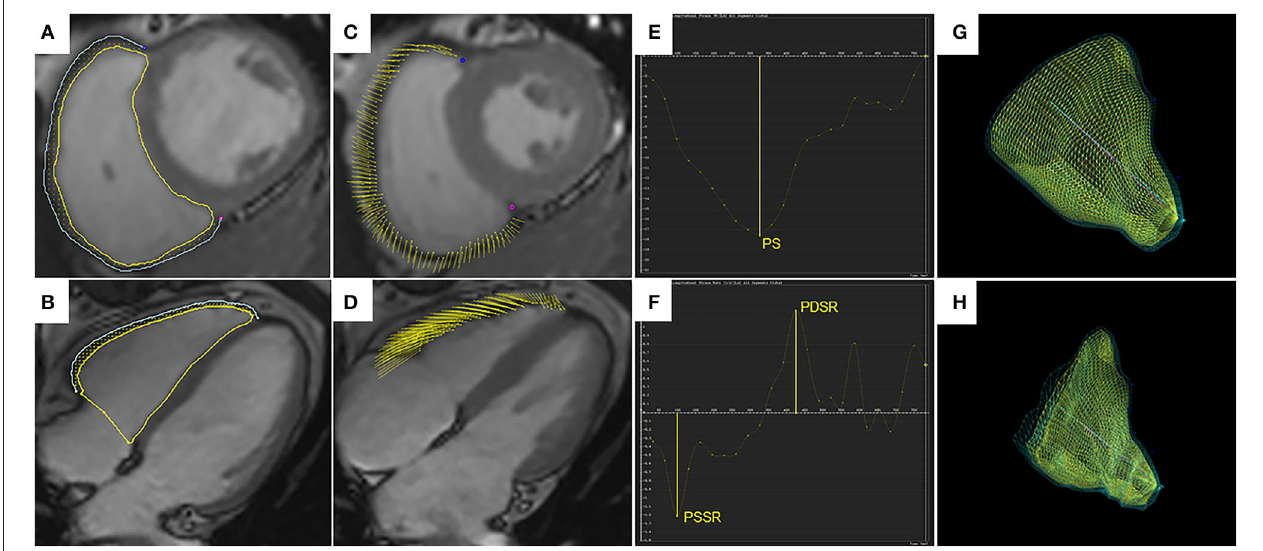
FIGURE 1 | Right ventricular tissue tracking using cardiac magnetic resonance imaging. Right ventricular (RV) contours are delineated on the short-axis SSFP image (A) and the four-chamber image (B) , shown for the end-diastolic phase. Yellow and blue lines represent RV endocardial and epicardial borders, and yellow dots between the borders represent myocardial points. (C,D) demonstrate myocardial points motion from the end-diastolic phase to the end-systolic phase using tissue tracking. (E,F) show strain curve and strain rate curve. The peak strain (PS) and strain rates (PSSR and PDSR) can be acquired in the curves. 3D models of the RV in the end-diastolic phase (G) and the end-systolic phase (H) . SSFP, steady-state free precession; PS, peak strain; PSSR, peak systolic strain rate; PDSR, peak diastolic strain rate; 3D,